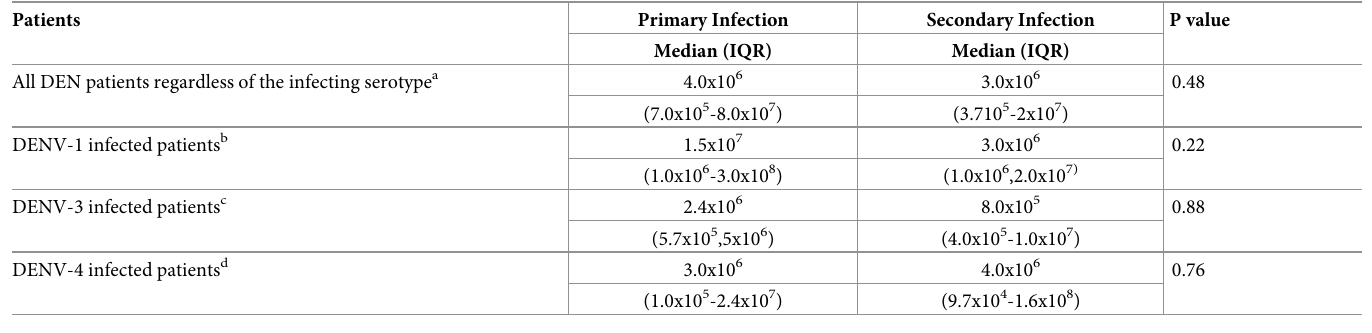
Table 2. Comparison of viremia levels of patients with primary and secondary DENV.